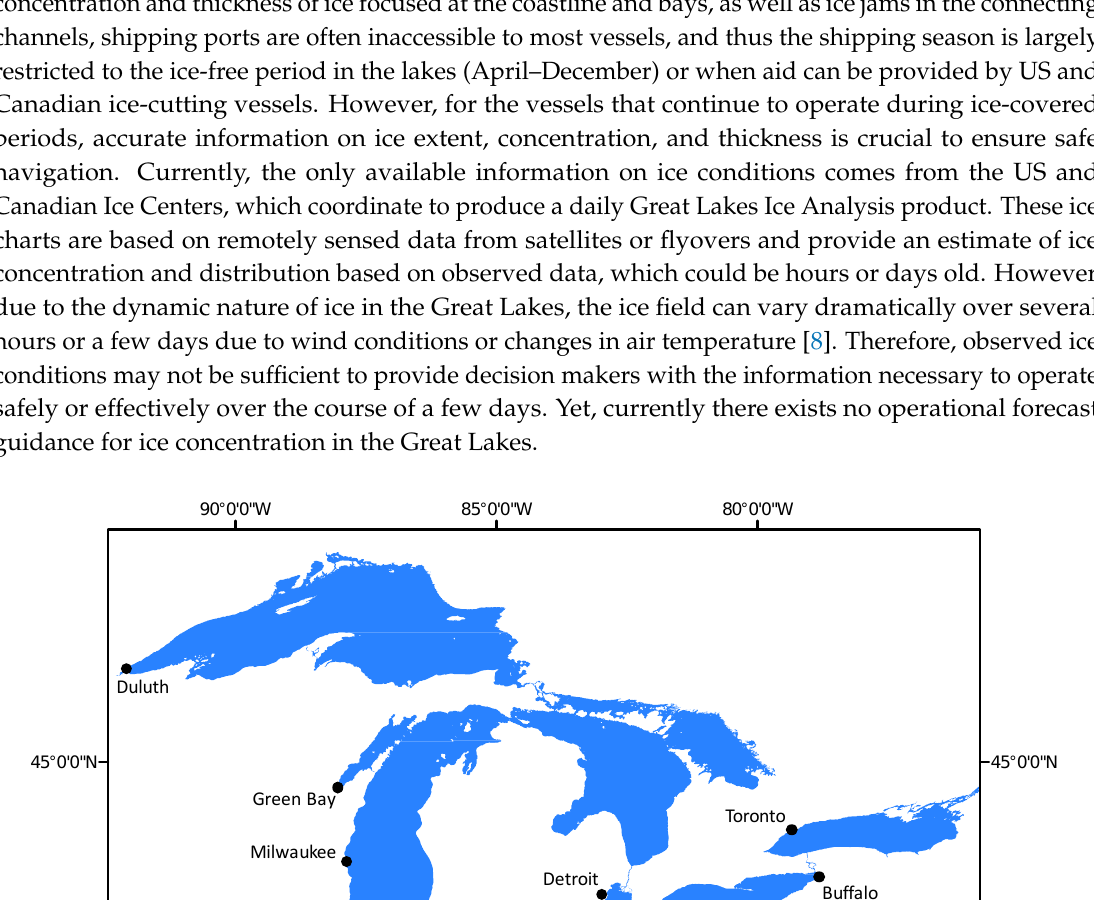
Table 1. Average annual maximum ice cover for the period 1973–2018.